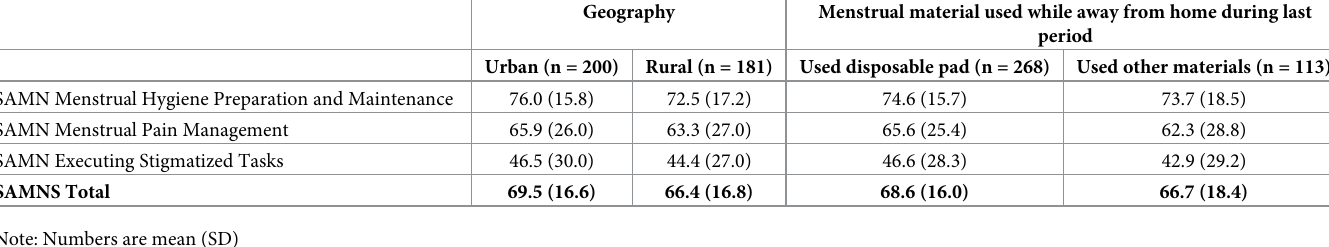
Table 5. Self-Efficacy in Addressing Menstrual Needs scores by geography and menstrual materials used while away from home during last menstrual period (n = 381).